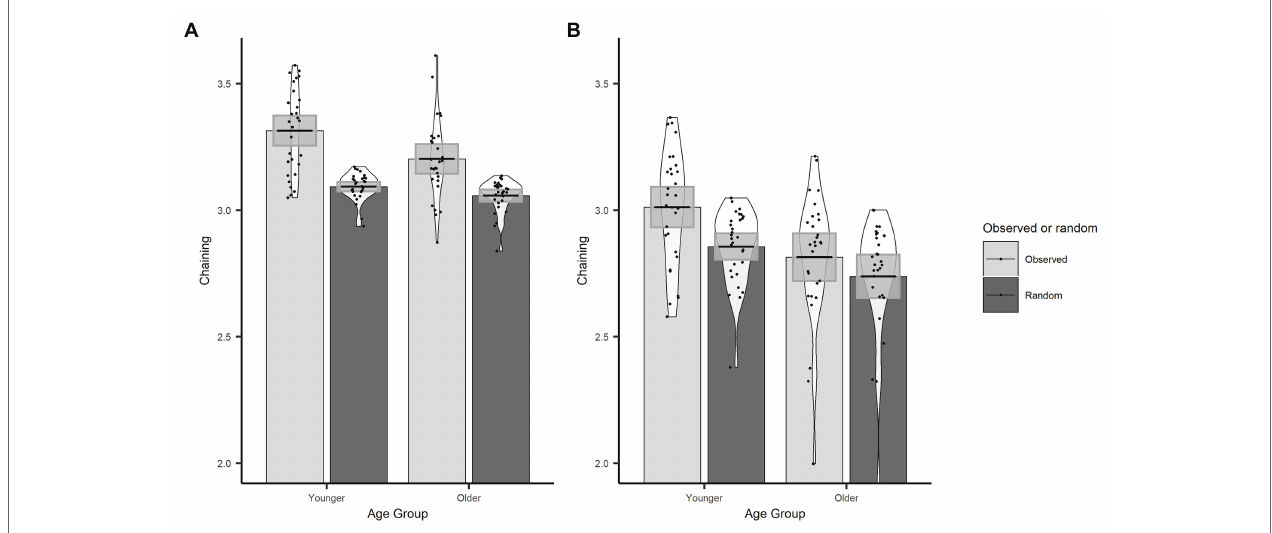
FIGURE 5 | Observed and randomized chaining across age groups with fixations on non-object ROIs removed (A) or included (B) . Plots show mean averages with confidence interval error bars, individual data points, and density